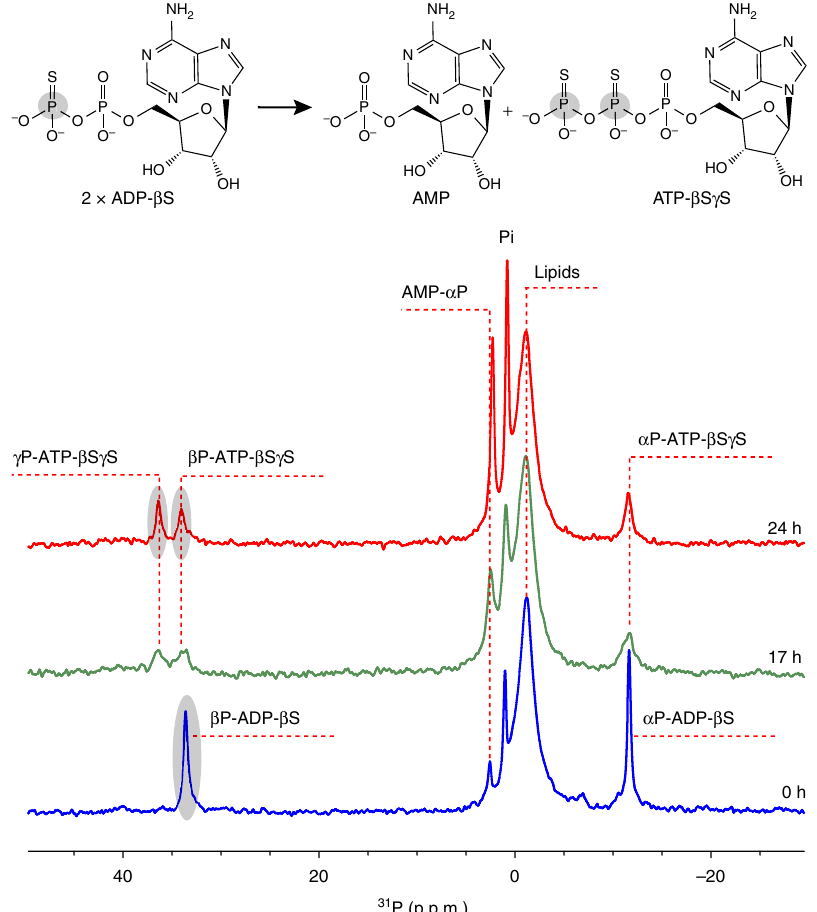
Figure 2 | Evidence for ATP synthesis by MsbA. ADP- b S is converted into AMP and ATP- b S g S, a non-hydrolysable ATP analogue. The a P and b P chemical shifts of ADP- b S are observed at (cid:2) 11.5 and 33.7 p.p.m., respectively. With time, the ADP- b S signals decay and the formation of ATP- b S g S is observed with signals at (cid:2) 11.5, 34.22 and 36.25 p.p.m. corresponding to a P, b P and g P,